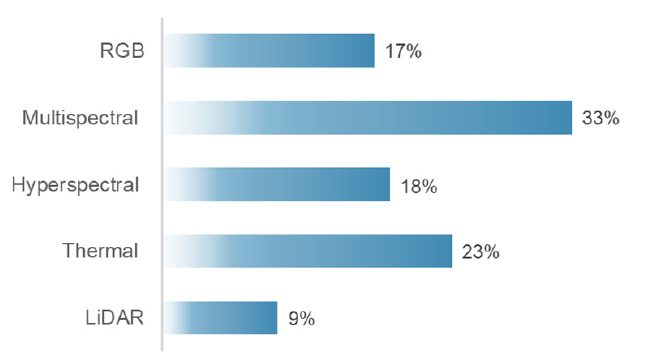
Figure 2. Analysis of percentage distribution of the most used sensors for vineyard monitoring over the past 23 years of research.